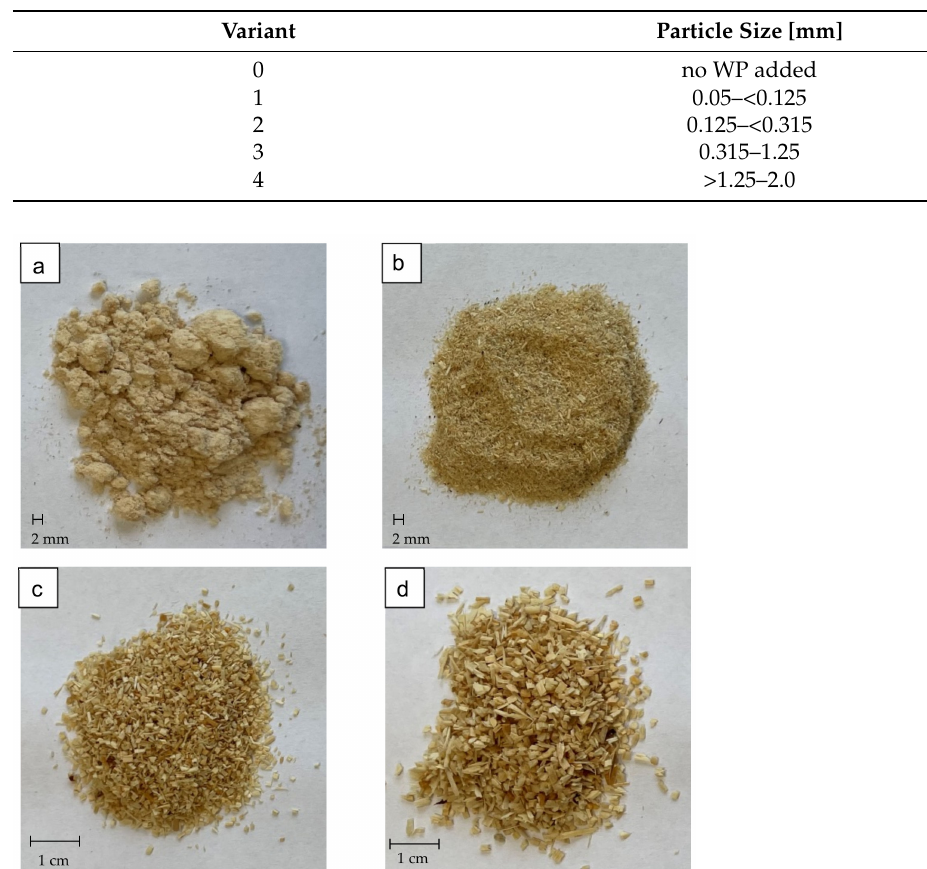
Table 1. Wood particle size used as a filler.